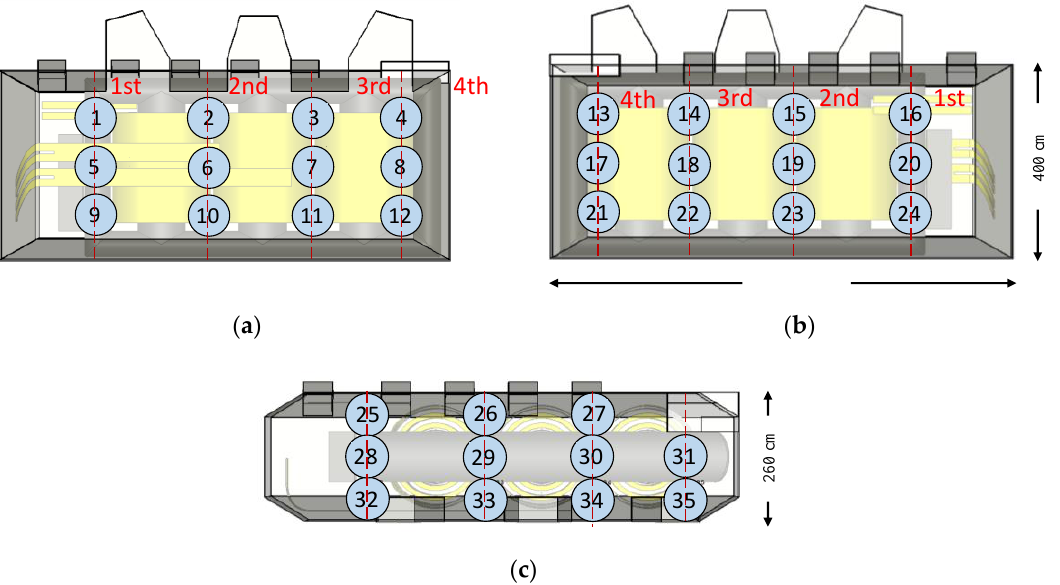
Figure 6. Complete transformer model with 35 ultra-high frequency (UHF) sensors for measurement with blue circles representing sensor positions and red lines representing cutting planes. ( a ) Front view; ( b ) Top view; ( c ) Rear view of transformer tank.